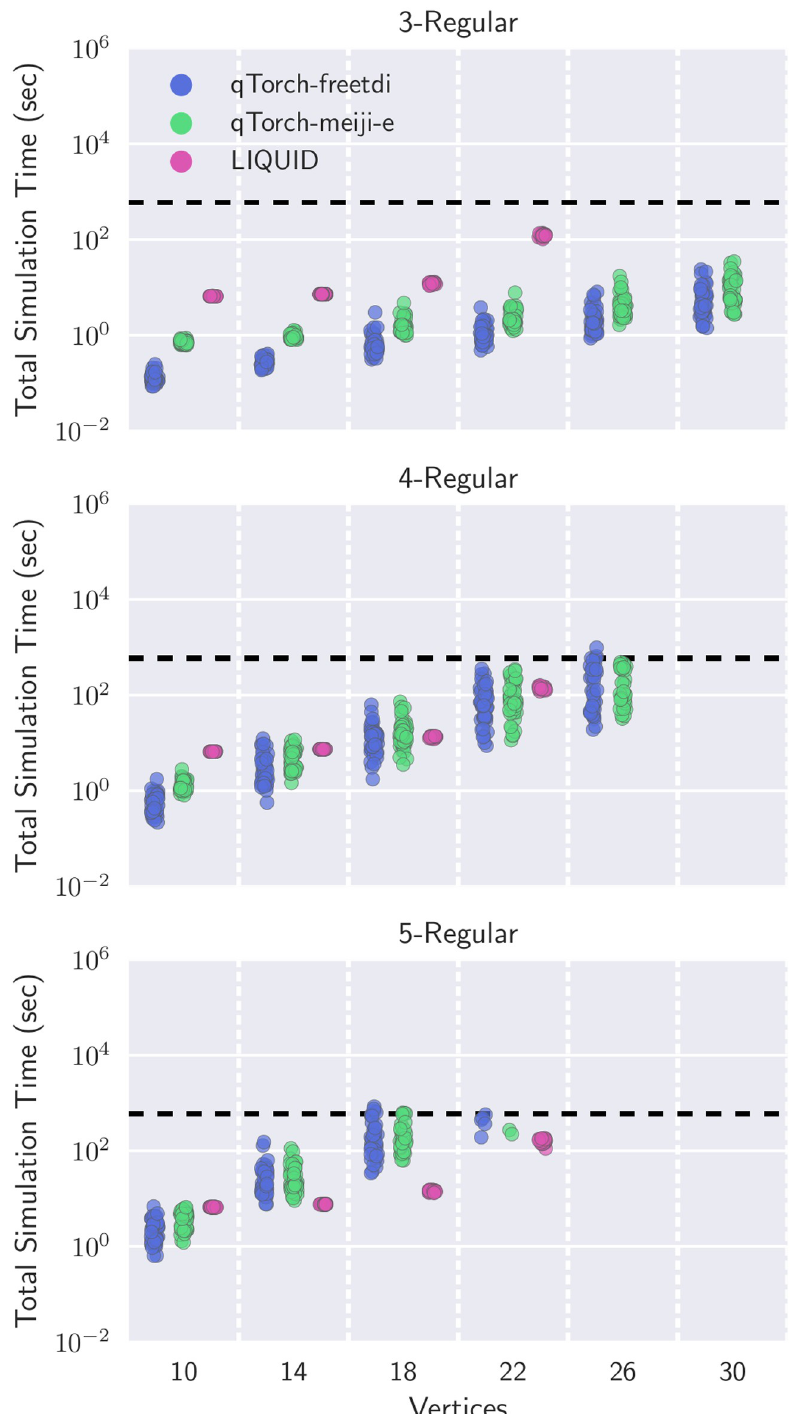
Fig 8. Simulation times of the qTorch tensor network simulator [19] with contraction sequences produced by exact treewidth algorithms vs. Microsoft’s LIQUID solver [25]. Total simulation time includes both computation of the contraction sequence using ConSequences and tensor network simulation time using qTorch. A timeout of 900 seconds is used for computing the contraction sequence (horizontal dashed line), and a simulation is not run unless an optimal contraction sequence is found by at least one contraction sequence algorithm. LIQUID is limited to simulations up to 22 qubits.